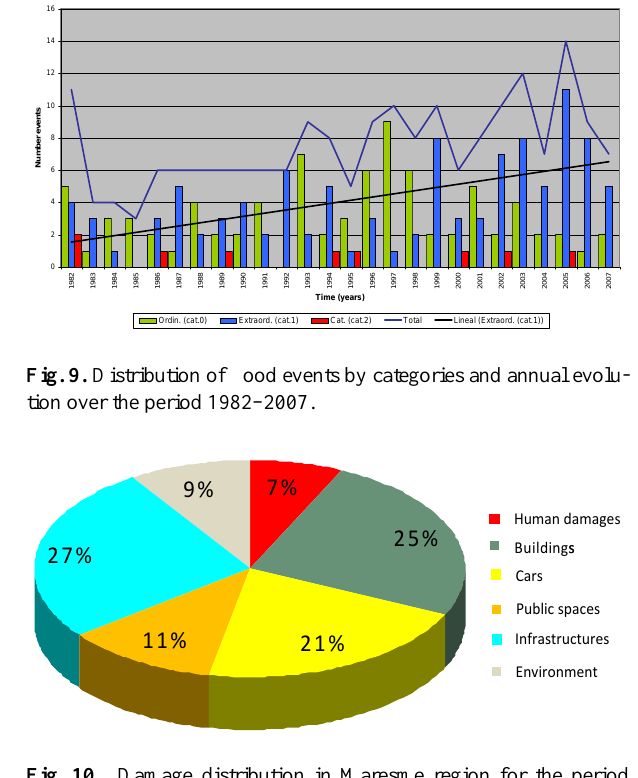
Fig. 10. Damage distribution in Maresme region for the period 1982–2007, as a consequence of flood Figure 10. Damage distribution in Maresme region for the period 1982-2007, as a consequence of flood events